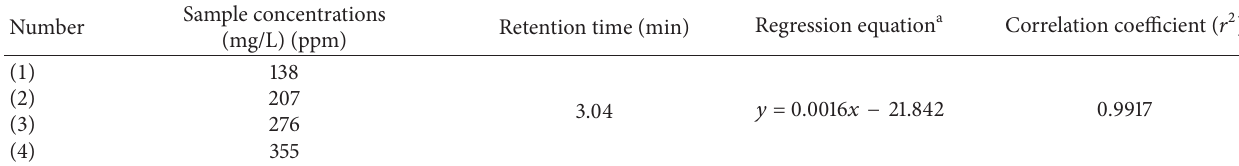
Table 1: Regression equation, retention time, and correlation coefficient of reference compounds on HPLC.